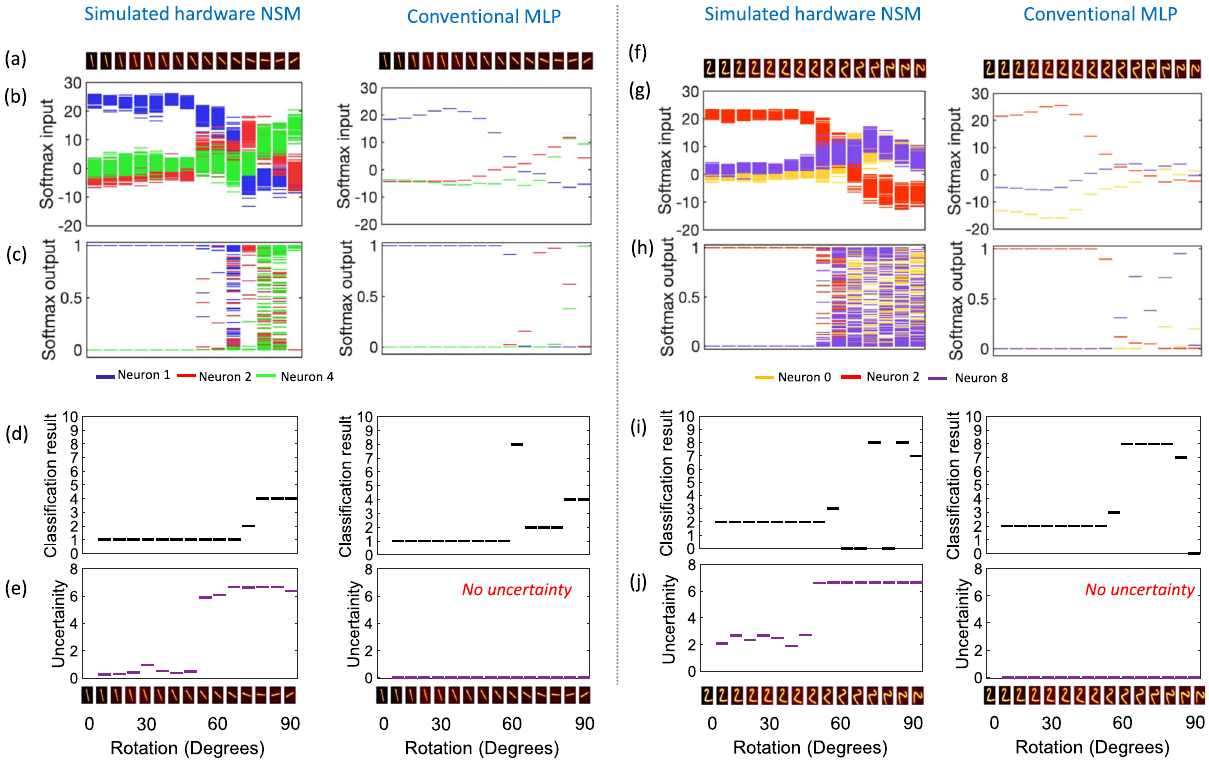
Fig. 5 Bayesian inferencing and uncertainty in data comparison between simulated hardware-NSM and a conventional MLP network. a , f Continuously rotated images of the digits 1 and 2 from the MNIST dataset, used for performing Bayesian inferencing. We perform 100 stochastic forward passes during the inference mode for each rotated image of digits 1 and 2 and record the distribution of the ( b , g ) softmax input and ( c , h ) softmax output for few representative output neurons. d , i Classi fi cation result produced by the NSM for each rotated image. e , j The uncertainty of the NSM associated with the prediction, calculated in terms of the entropy H = − Σ p *log ð p Þ , where p is the probability distribution of the prediction. When the NSM makes a correct prediction (classifying image 1 and 2 as belonging to class 1 and 2, respectively), the uncertainty measured in terms of the entropy remains 0. However, in the case of wrong predictions, the uncertainty associated with the prediction becomes large. MLP multilayer perceptron, NSM neural sampling